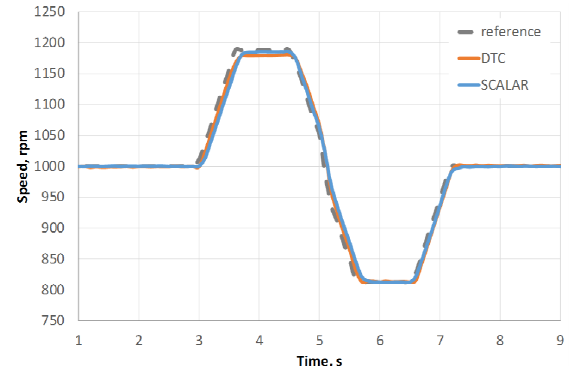
TABLE I. ANALYSIS OF DIFFERENT SPEED PROFILES OF THE TESTED DRIVE.